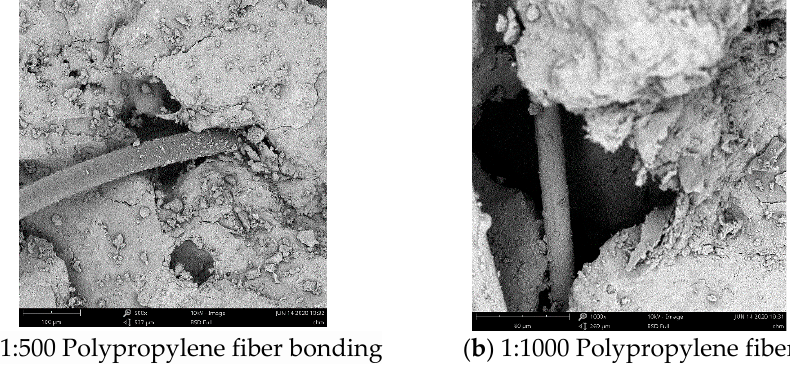
Figure 7. SEM of polypropylene fiber mortar.